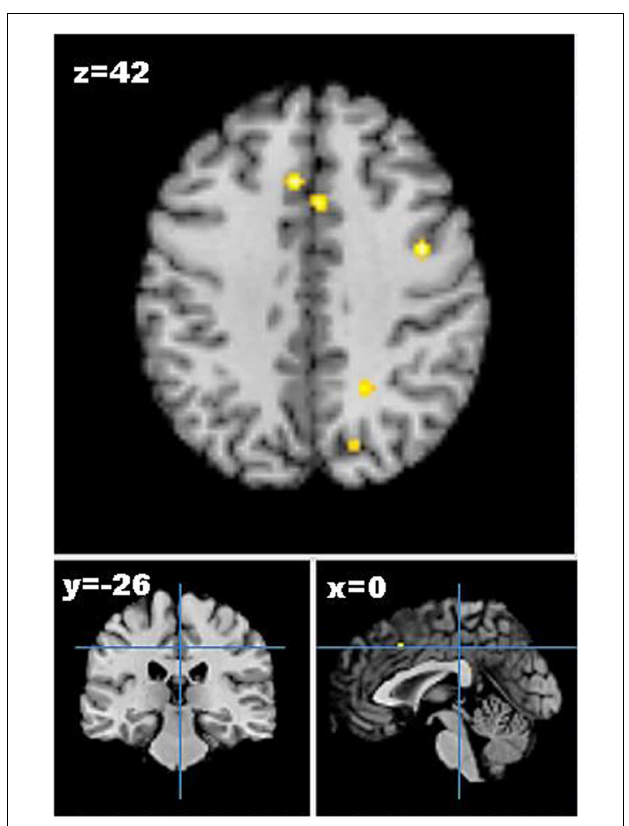
FIGURE 2 |Axial ( z ), coronal ( y ), and sagittal ( x ) views of decreased activation in studies comparing neural activation to visual food cues from pre- to post-weight loss, as detected by fMRI . FDR corrected P < 0.05, cluster size > 100mm 3 , region of interest studies excluded. Figure shows decreased activation from pre- to post-weight loss in the cingulate gyrus, middle frontal gyrus, and